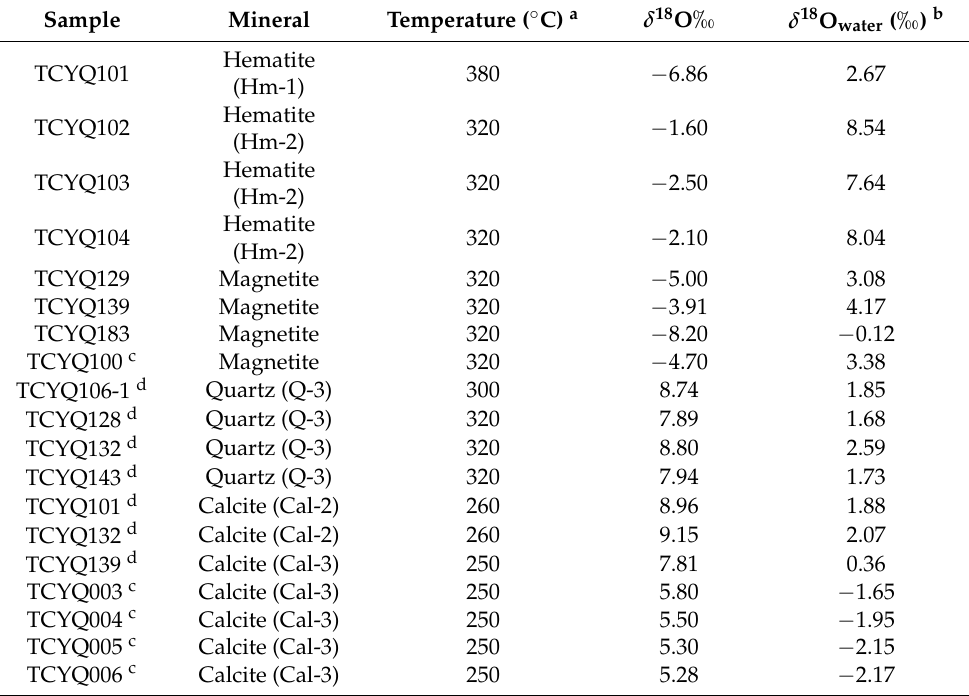
Table 1. Oxygen isotope values of fluid inclusions and host minerals in the Taochong deposit.